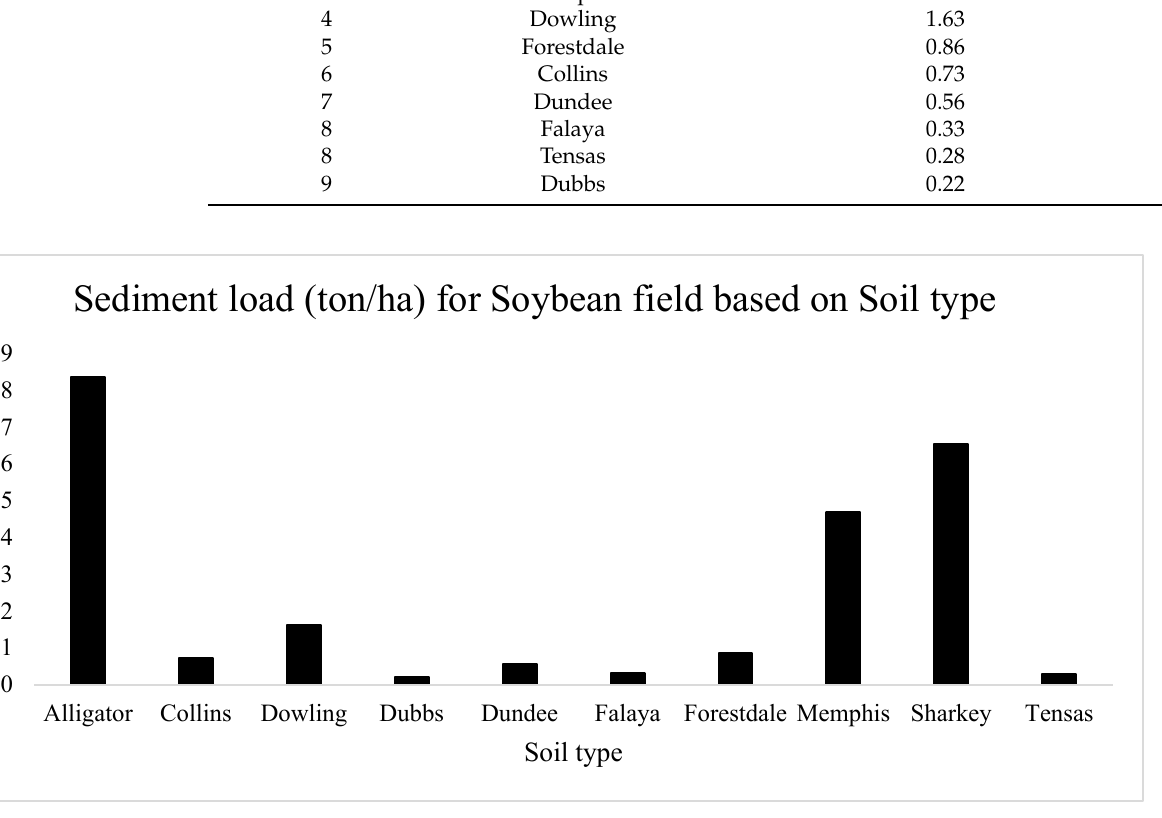
Figure 4. Comparative analysis among major soils in the agriculture dominant region.